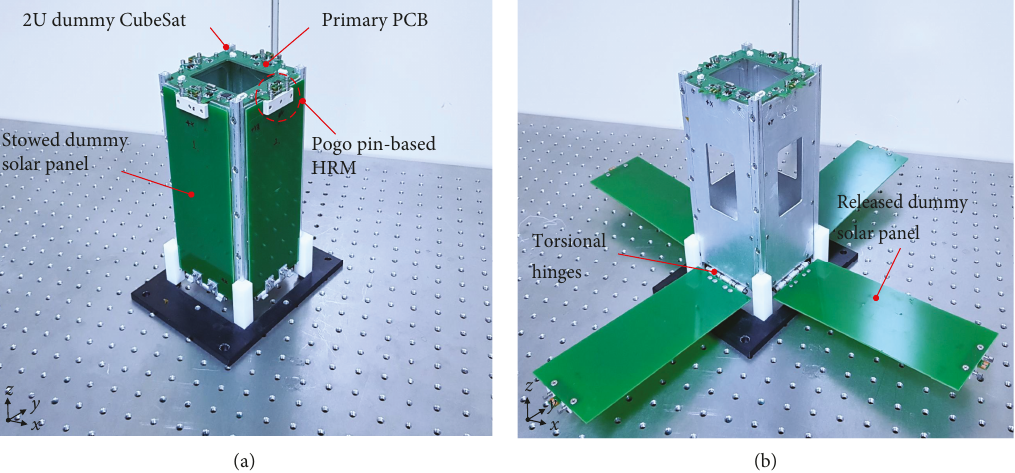
Figure 1: Con fi gurations of pogo pin HRM in a 2U dummy CubeSat: (a) stowed con fi guration and (b) deployed con fi